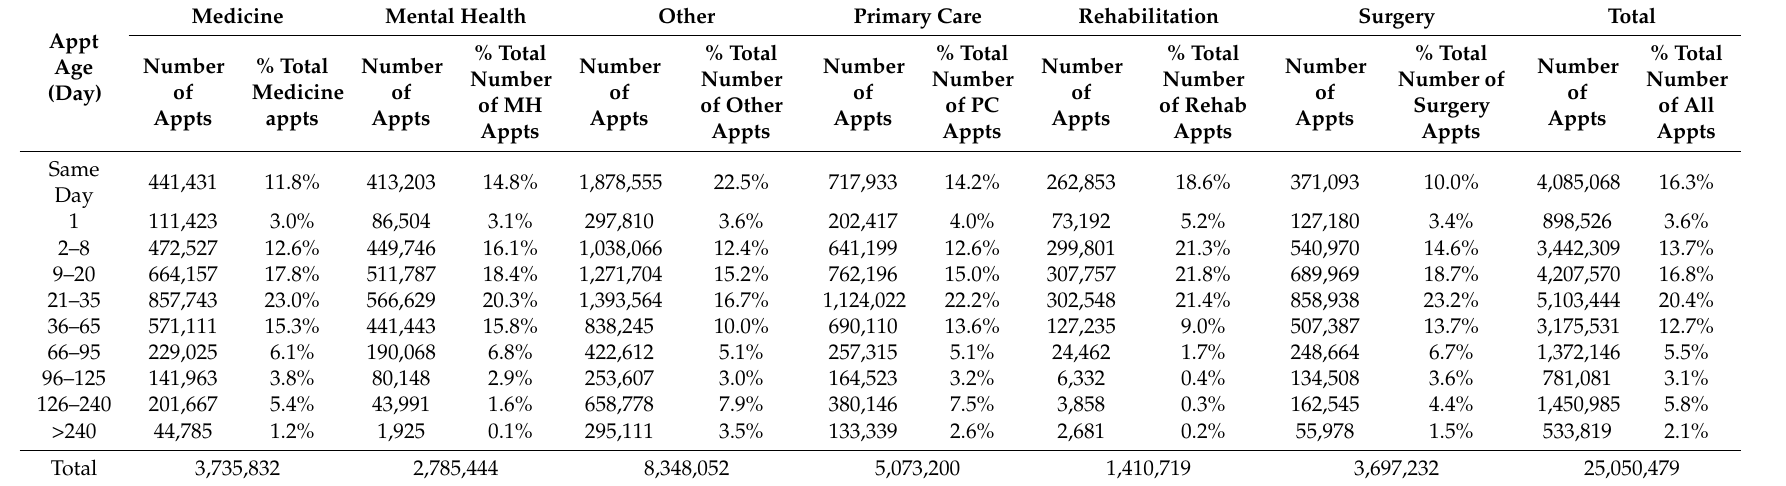
Table 5. Appointment frequencies and percentages for all service lines by appointment age